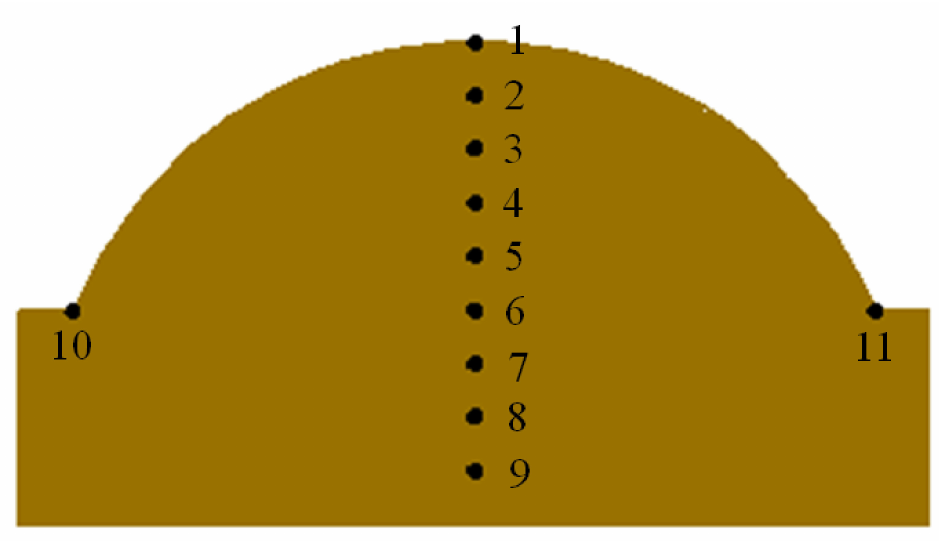
Figure 3. Sample points locations and number.